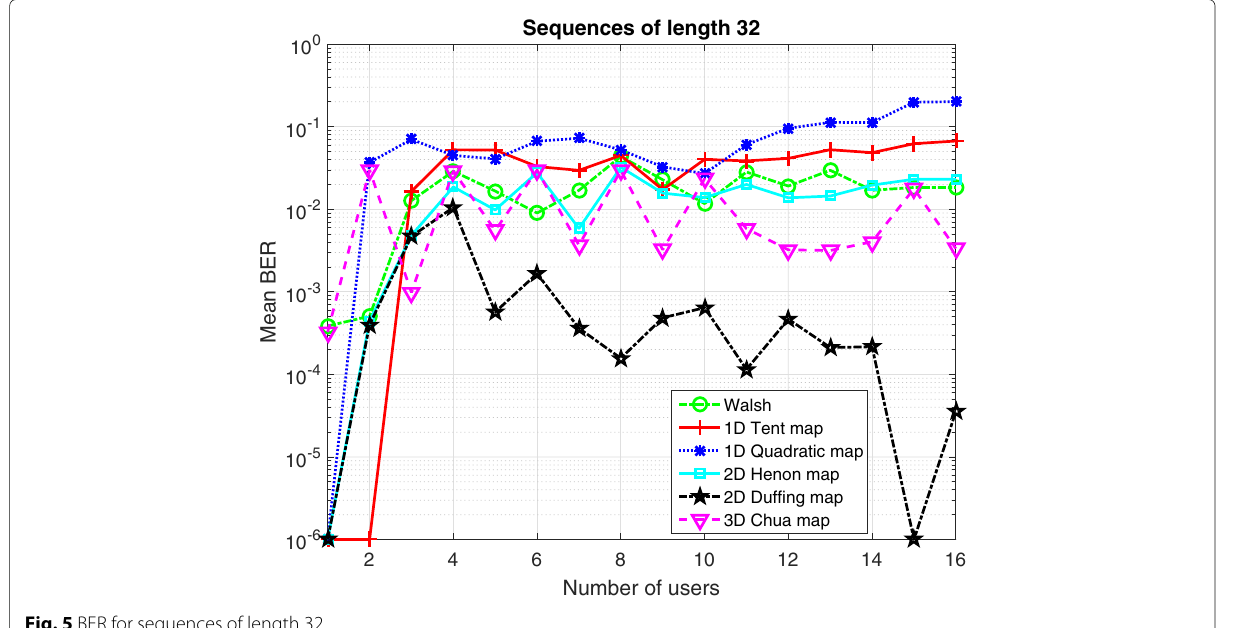
yield the best performance results. Low figure of merit means low sidelobe energy that result in better autocor- relation function with more energy in the main peak. Main peak is used for synchronization and despreading, therefore, it is ideal to have as much energy as possible